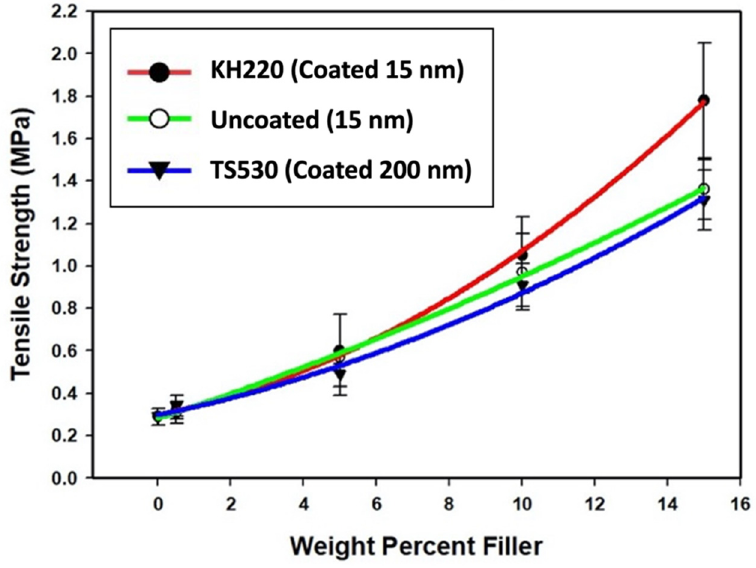
Figure 8. Plots of Tensile Strength (MPa) Versus Weight Percent Filler For Three Filler Types. Error Bars Represent Standard Errors of Means.